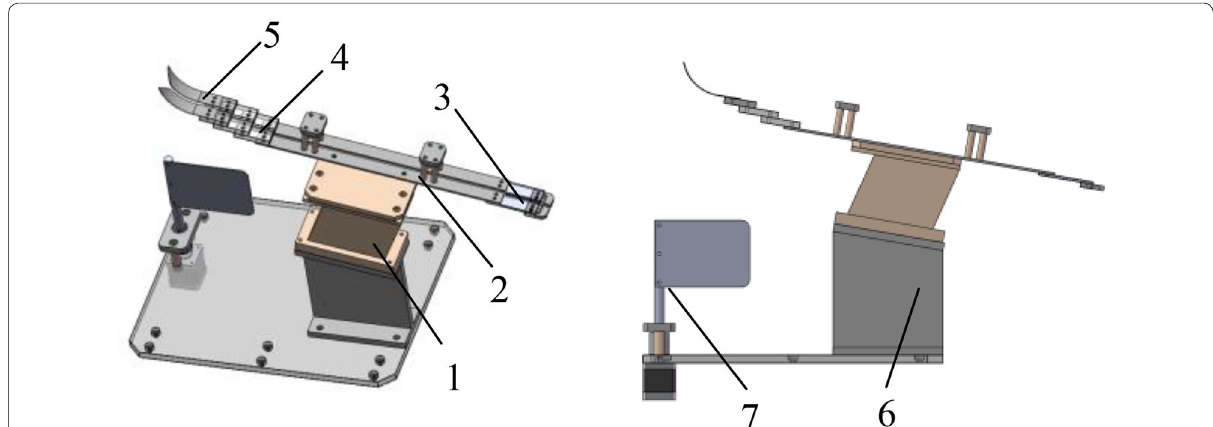
Figure 8 Automatic sorting and conveying mechanism diagram. 1. Electromagnetic linear vibration feeder; 2. Channel; 3. Blocking component; 4. Ladder assembly; 5. Channel mouth; 6. Support; 7. Swing